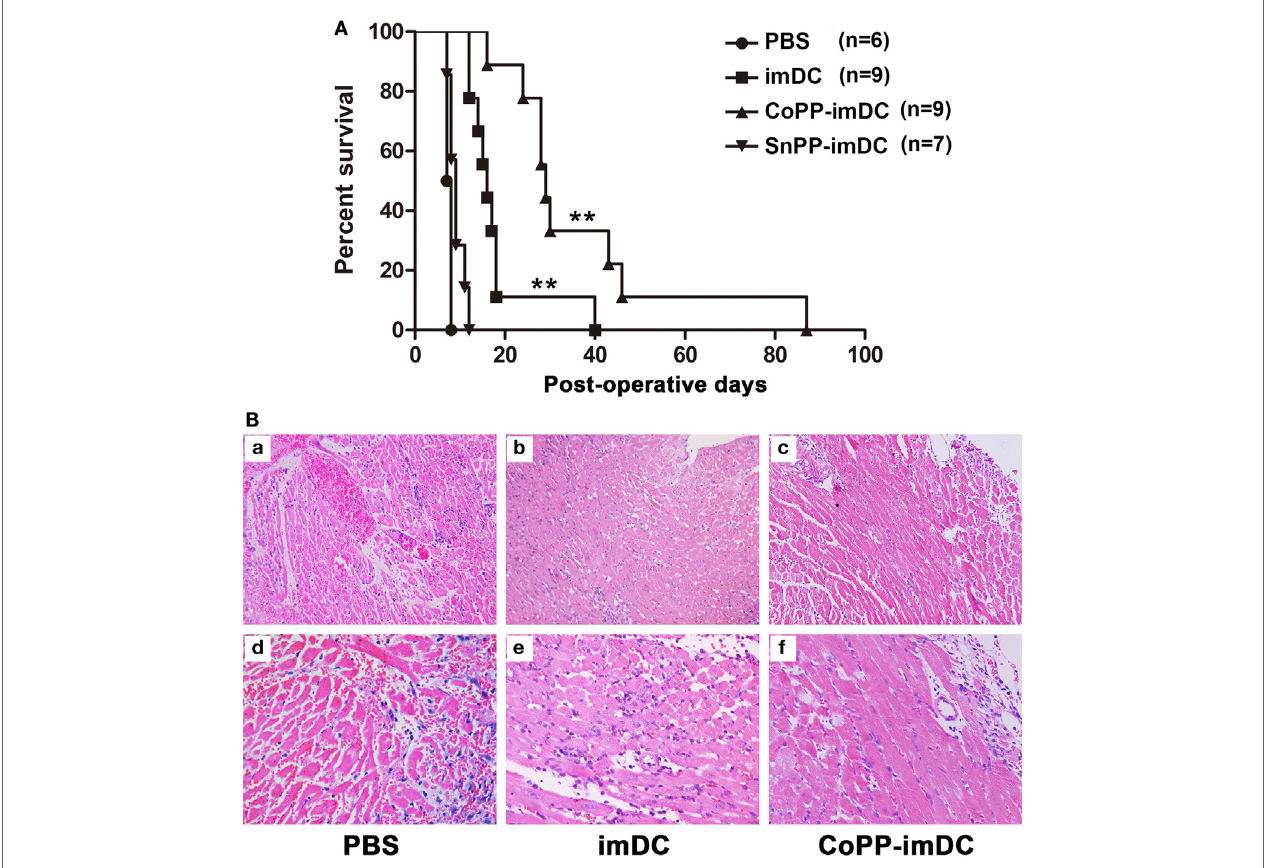
FigUre 4 | Donor-derived HO-1 hi immature dendritic cells (imDCs) are more efficient in modulating allograft rejection and prolonging heart allograft survival. Untreated, cobalt protoporphyrin (CoPP)-pretreated, or SnPP-pretreated BALB/c mouse-derived imDCs (5 × 10 6 ) were injected intravenously into C57BL/6 recipients 7 days before cardiac transplantation. As a control, recipient mice received no cell transfusion, and only injection with the same volume of PBS. (a) The kinetics of cardiac allograft survival rates for all study groups are shown (** P < 0.01, untreated imDC group vs. both control group and SnPP-pretreated imDC group; CoPP-pretreated imDC group vs. untreated imDC group; n = 6–9 per group); (B) hematoxylin and eosin staining was performed to assess the pathological changes in allografts harvested at day 7 posttransplant in the PBS control group, untreated imDC group, and CoPP-pretreated imDC group (a–c: magnification, 100 × ; d–f: magnification, 200 ×